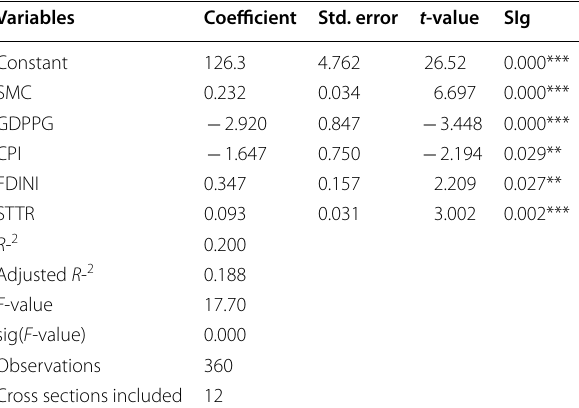
Table 5 Penal fixed